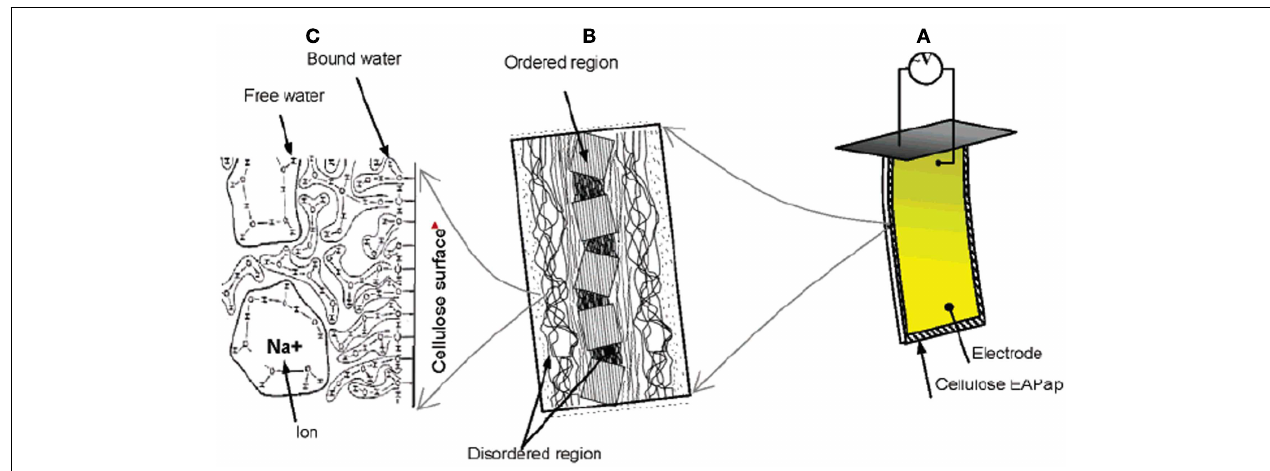
FIGURE 1 | Concept of EAPap bending actuator: (A) EAPap actuator, (B) cellulose microfibril, and (C) water molecules bonded with hydroxyls . Adapted with permission from Kim et al.